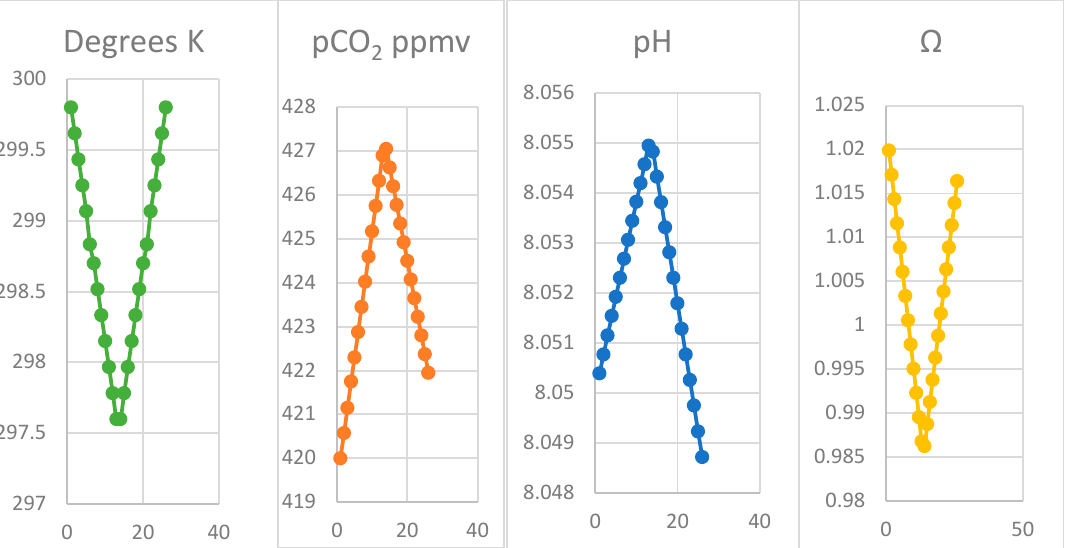
Figure 5. Estimated variations (Oct–Sep) in seawater temperature, pH and saturation ( Ω ) for calcite at Hilo and p CO 2 on Mauna Loa for 26 periods per year (x-axis, temperature × time); only for temperature is the original condition regained. Table 3. Results from Thermal program of cooling process from peak seawater temperature